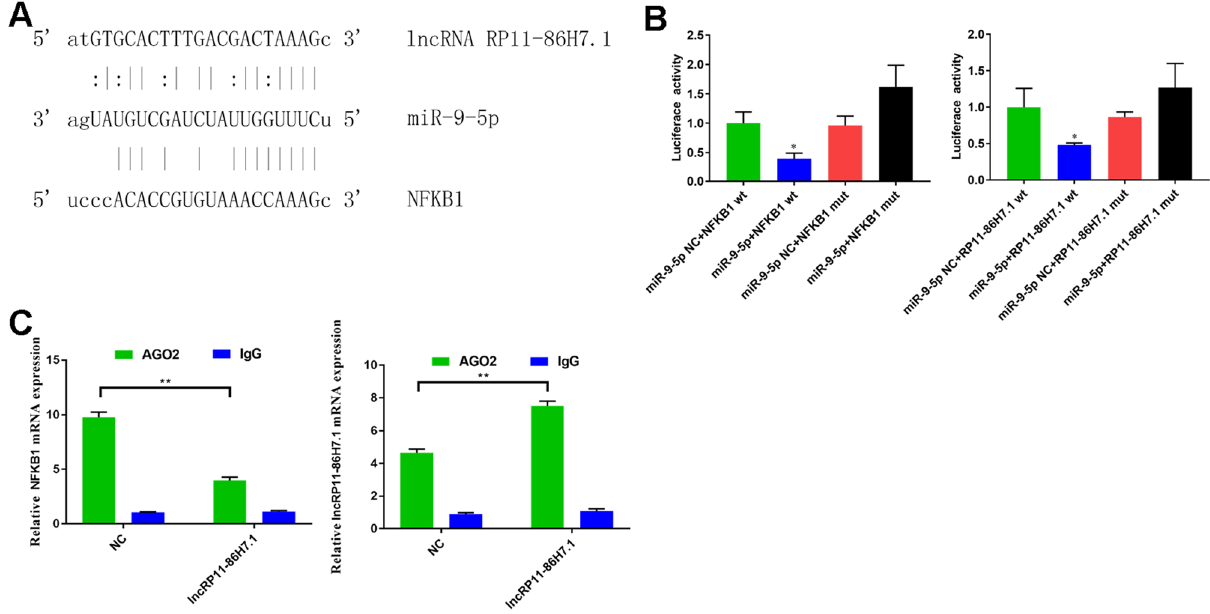
Figure 6. LncRNA RP11-86H7.1 acts as a ceRNA and competitively absorbs miR-9-5p with NFKB1. ( A ) LncRNA RP11-86H7.1, miR-9-5p and NFKB1 binding sites predicted by miRanda. ( B ) The luciferase activities in 293 T cells co-transfected with wild-type (wt) and mutant (mut) NFKB1 or RP11-86H7.1 plasmid together with miR-9-5p mimic or miR-9-5p negative control (NC). Luciferase activity was detected 24 h after transfection using the dual luciferase assay. Data are presented as the relative ratio of renilla luciferase activity and firefly luciferase activity. ( C ) The real-time PCR results of the RIP based on Ago2 showed that lncRNA RP11-86H7.1 can compete with the NFKB1 for the binding of miR-9-5p. IgG was used as negative control. The data are shown as the means ± standard deviations (n = 3). The statistical significance of the data was assessed by Student’s t test. * P < 0.05, ** P <